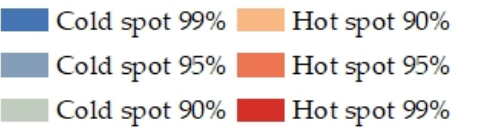
Figure 5. Getis and Ord analysis after DRSA results. Each group describes the clusters obtained from the Getis–Ord analysis applied to the year of